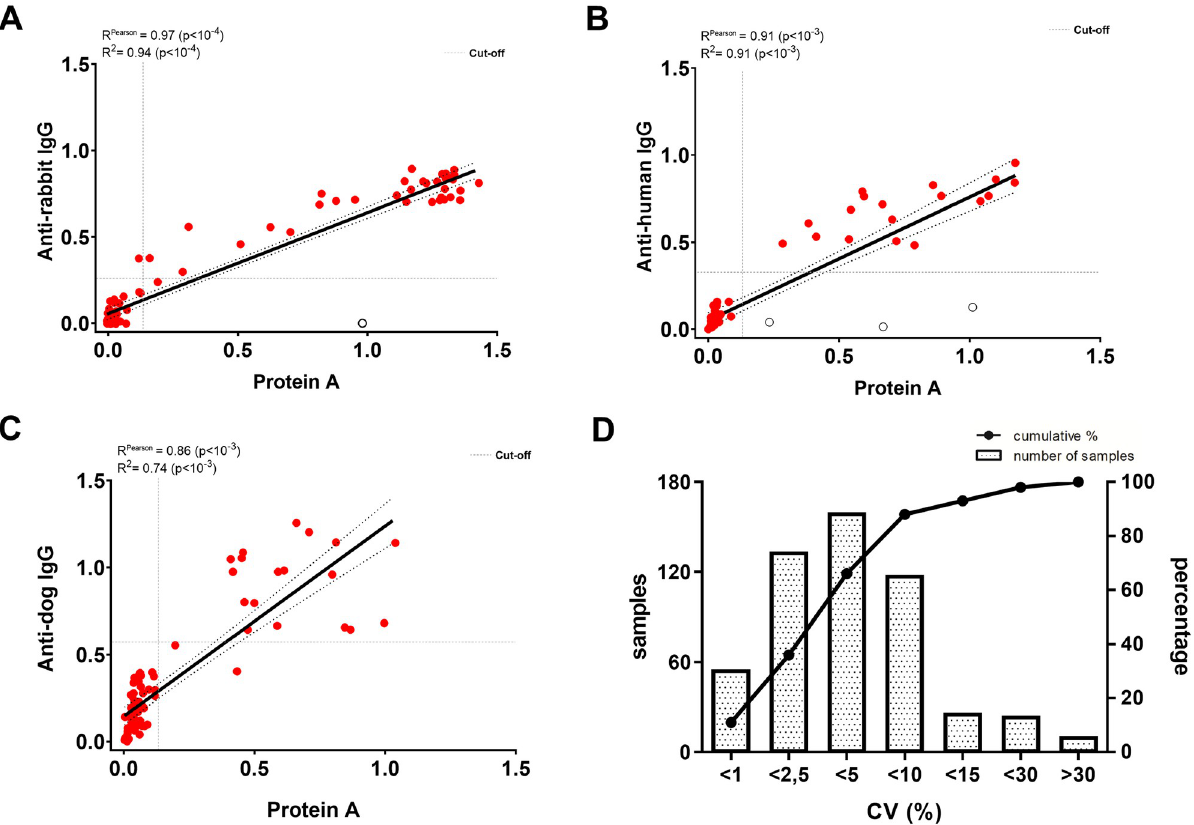
Fig 3. Linearity and precision of Protein A-ELISA. Correlation between the Protein A and IgG ELISA tests using control rabbit sera (n = 81) (A) ; human sera (n = 64) (B) and dog sera (n = 77) (C) . Dashed lines represent the 95% confidence interval and the white data points represent outliers excluded from correlation analysis. From the total 553 samples tested for Protein A-ELISA, 88% had a coefficient of variation (CV) of the triplicates lower than 10% and 93% of the samples had a CV lower than 15%. The line shows the cumulative percentage of samples within the respective CV level and the bars show the absolute amounts of samples in each interval of CV value (D)